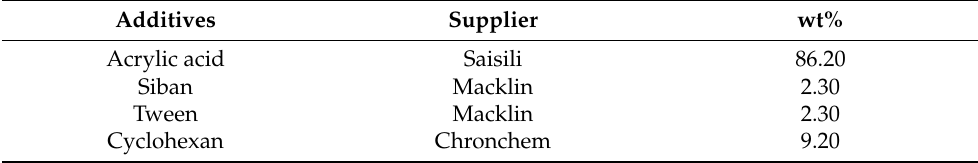
Table 1. Clear-coat resin.